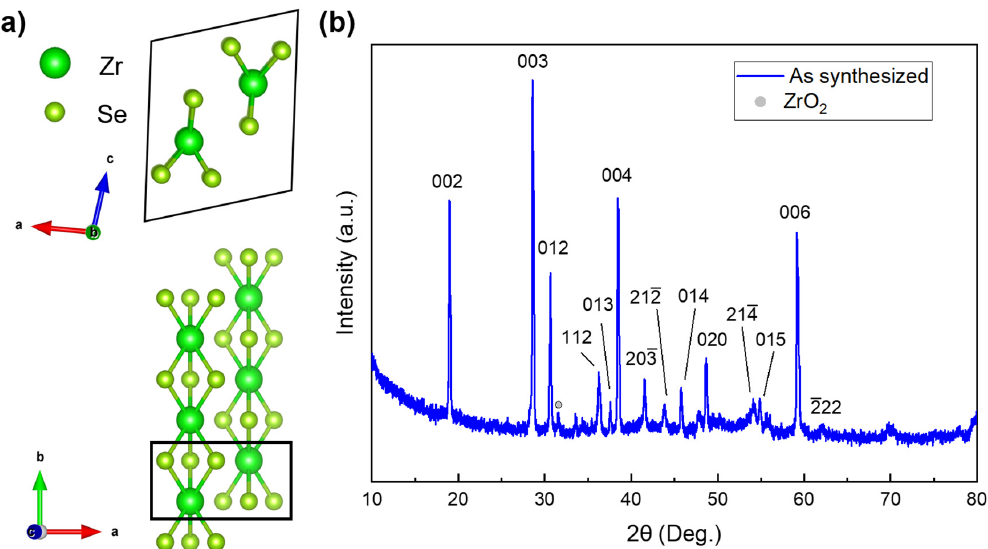
Figure 1. ( a ) Crystal structure of ZrSe 3 . Each Zr atom bonds to six neighbor Se atoms, forming a triagonal prism. ( b ) Indexed powder XRD pattern of the ZrSe 3 sample.